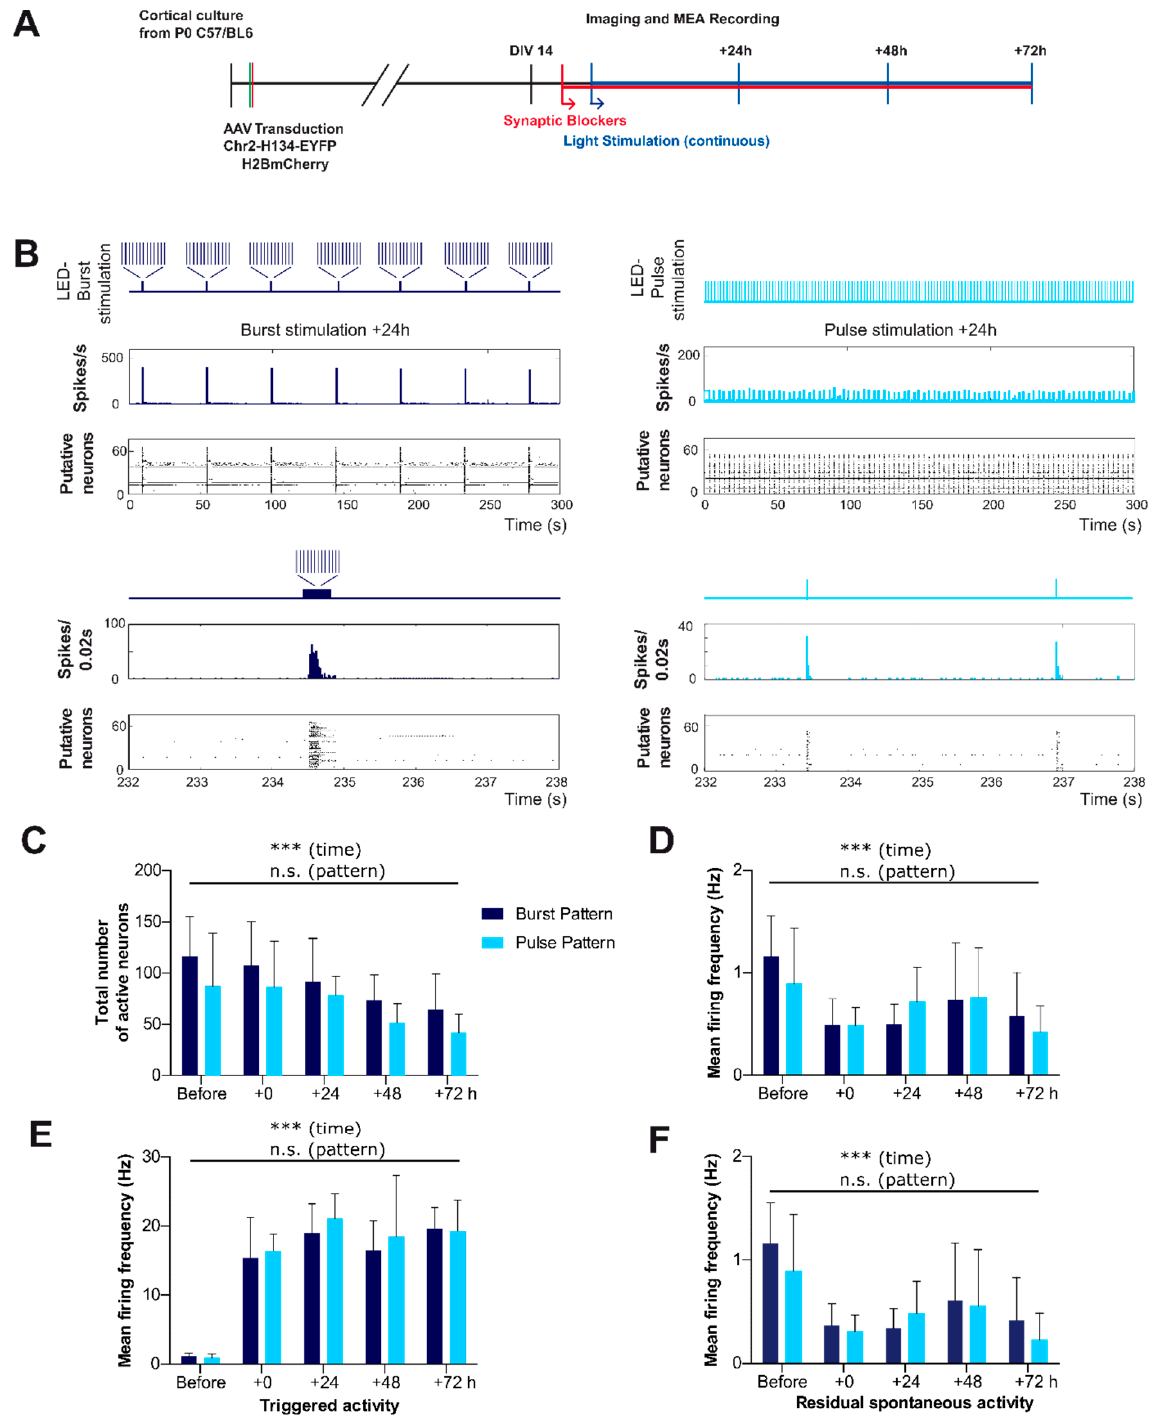
Figure 5. Chronic optogenetic stimulation allows alteration of neuronal activity. ( A ) Schematic overview of the experimental design. Cortical cultures from P0 C57/BL6 mice were transduced with ChR2-H134-EYFP and H2B-mCherry at DIV2 and allowed to mature for two weeks. Before and after blockade of synaptic transmission by application of glutamatergic and GABAergic receptor antagonists (CNQX, D-APV, and GBZ) at DIV14, cultures were imaged, and MEA activity was recorded for 5 min. Imaging and recording were repeated every 24 h for up to 72 h until DIV17. ( B ) Example raster plots and time histograms of cortical cultures under physiological burst stimulation (left) and non-physiological pulse stimulation (right) 24 h after the start of the chronic experiment. Note that burst stimulation elicits bursts alternated with periods of relative silence and that pulse stimulation activates neurons almost continuously at a slow pace. Lower panels: periods with single burst stimulation or two pulse stimuli at higher temporal resolution. ( C , D ) Comparison of the mean number of active neurons ( C ) and the mean firing frequency ( D ) before and during the chronic light stimulation with either burst and pulse stimulus pattern does not reveal a significant difference between the two stimulus paradigms